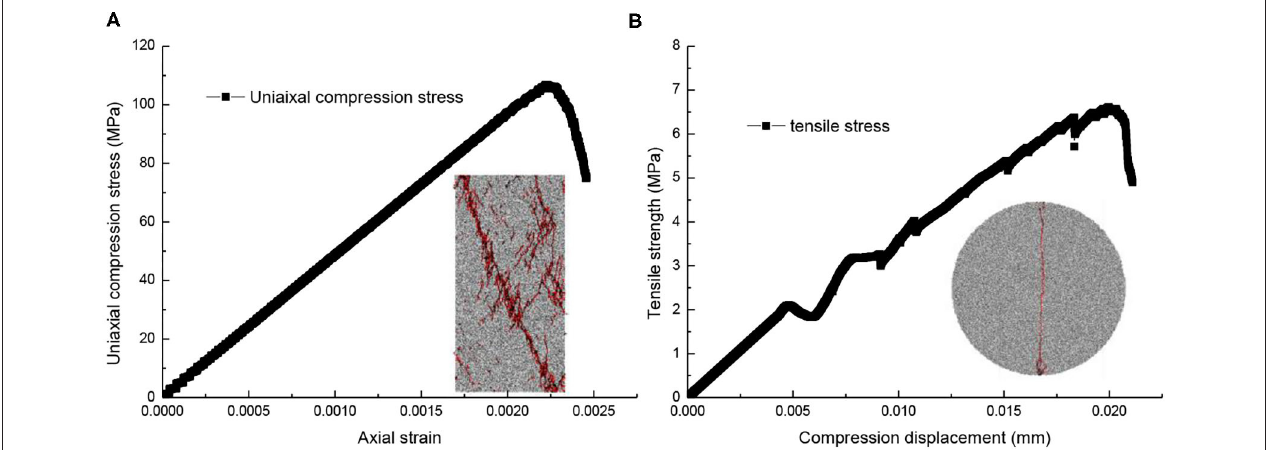
FIGURE 2 | Calibration results: (A) and (B) correspond to UCS and TS, respectively.